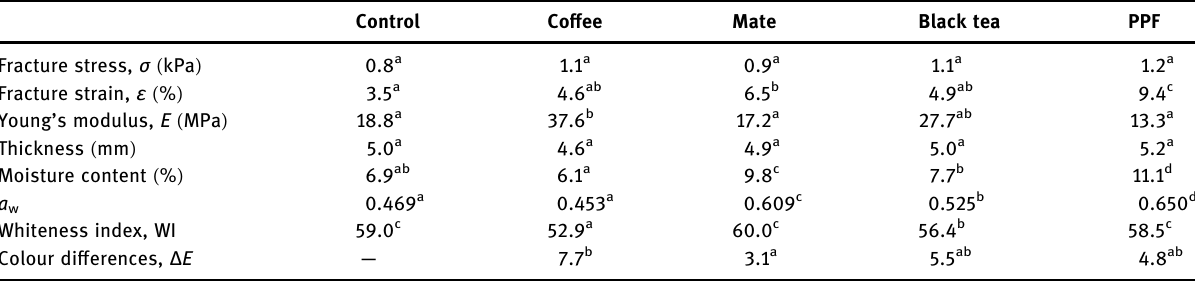
Table 6: Physical characteristics of gluten - free biscuits prepared from 25:25:25:25 rice fl our:cassava starch:maize starch:chickpea fl our blend with infusions or Prosopis chilensis pod fl our ( PPF